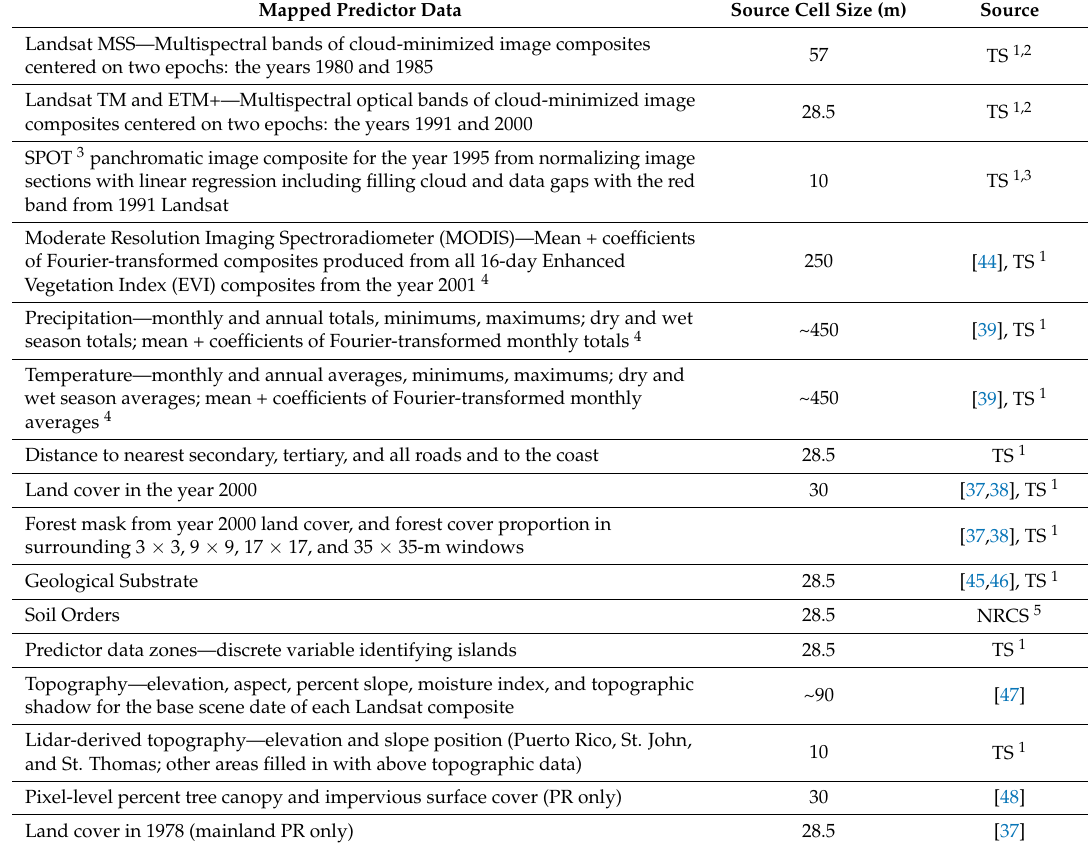
Table 1. Mapped predictor data. TS = Developed for this